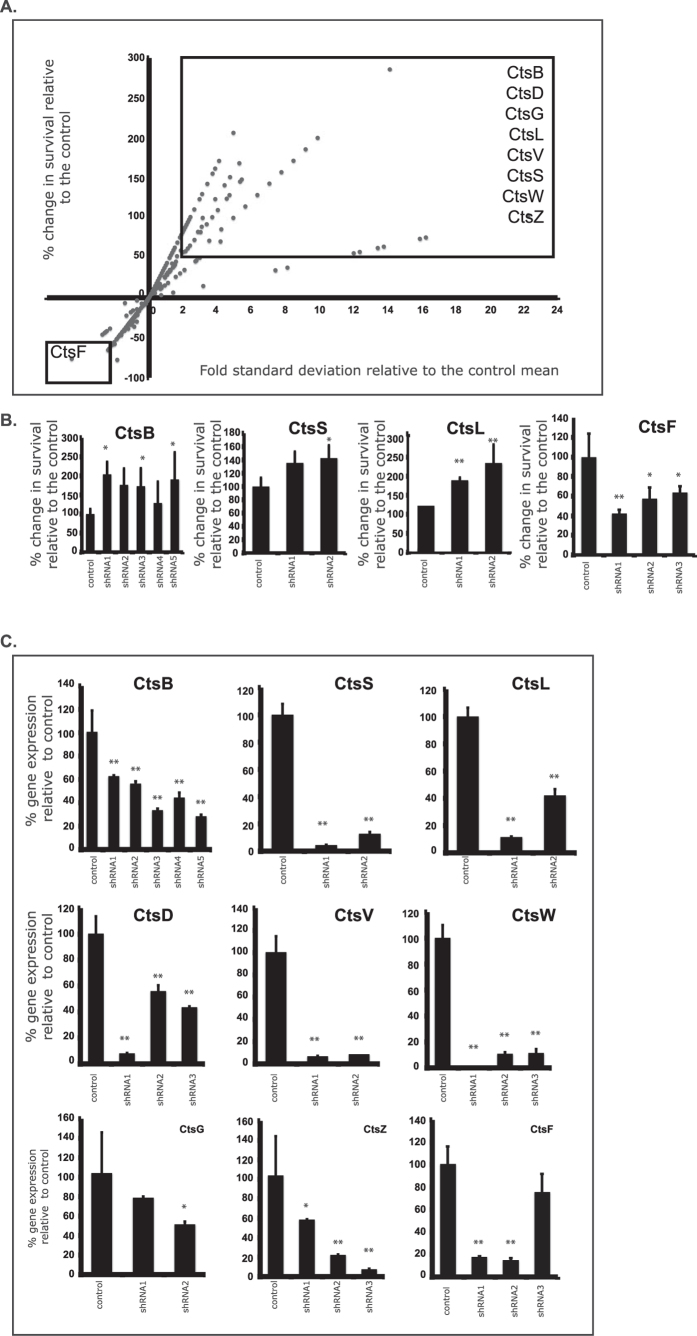
Medium-throughput analysis of the effects of cathepsins and cystatins on MTB intracellular survival within human macrophages.(A) Distribution of individual shRNA scores obtained from two independent screens. shRNAs were selected as “hits” (boxed dots) when there was an increase or decrease of MTB survival of >50%, and also of >2 standard deviations from the mean of the controls. (B) Quantification of the percentage of MTB survival within macrophages knocked down for cathepsins B, S, L and F. Only the shRNAs that produced stable puromycin-resistant cell lines are shown (*p < 0.05; **p < 0.01 relative to control; n = 5). (C) Quantification of cathepsin gene expression knock down in macrophages relative to control (*p < 0.05; **p < 0.01 relative to control; n = 4). Up to 5 shRNA lentivirus constructs were used per experiment.